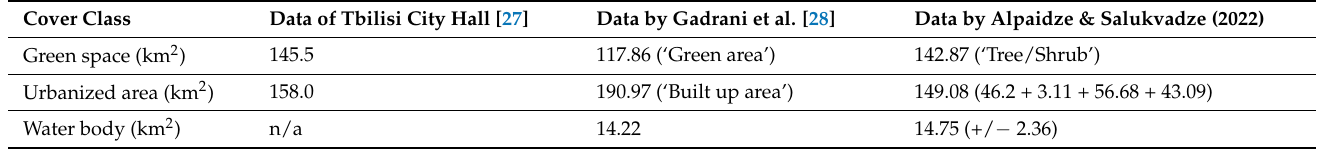
Table 6. Comparison of selected research and official data of distribution of green spaces